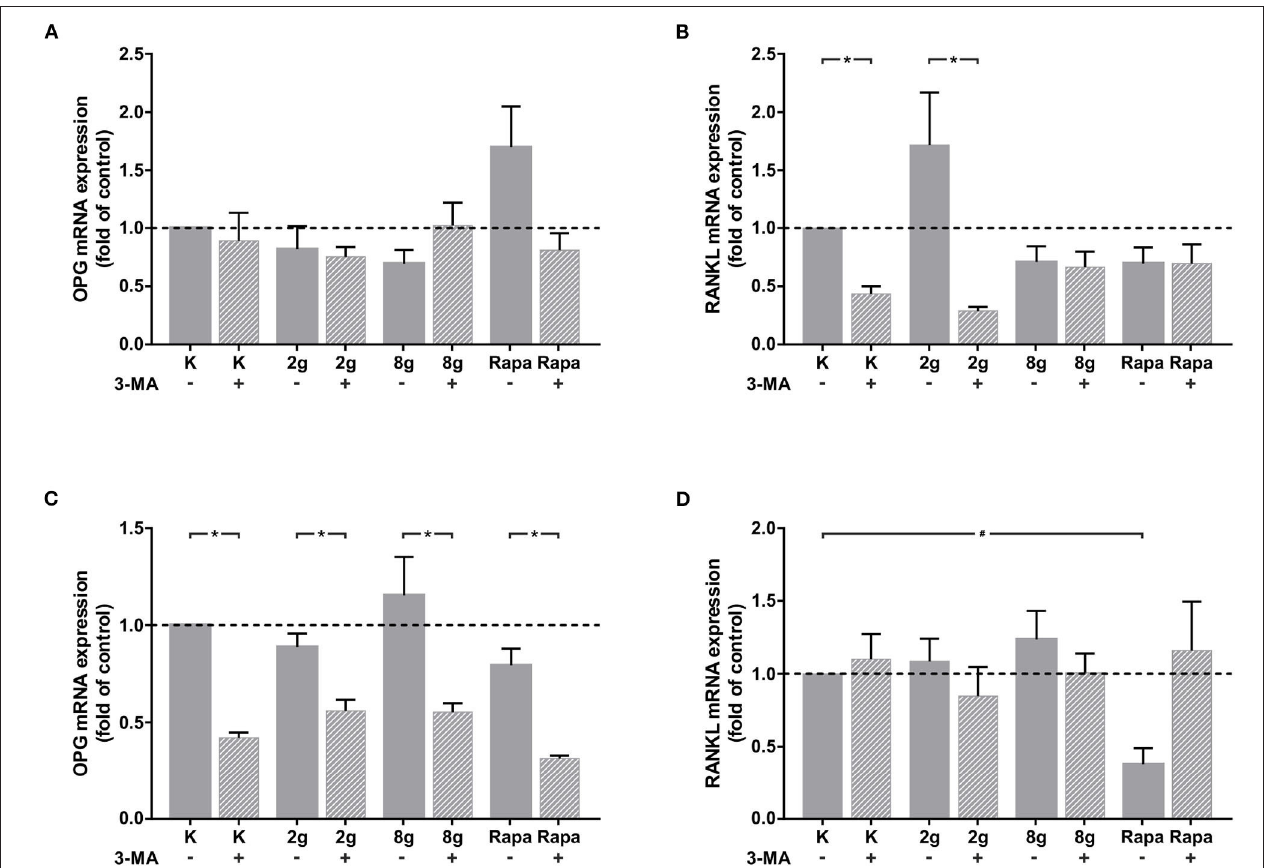
FIGURE 5 | (A) Effects on opg gene expression in phAOBs after 24 h cultivation without sIL-6R and with supernatant from hPDL fibroblasts with or without autophagy inhibitor 3-MA, treated with mechanical stimulation (2 or 8 g/cm 2 ) or Rapamycin (Rapa; 50 nM) for 16 h. Mean ± SEM ( n = 6); # significant ( p < 0.05) difference between groups as determined by Dunnett’s T -test. ∗ significant ( p < 0.05) difference between two groups (uninhibited and inhibited) as determined by the Mann-Whitney-Test. (B) Effects on rankl gene expression in phAOBs after 24 h cultivation without sIL-6R and with supernatant from hPDL fibroblasts with or without autophagy inhibitor 3-MA, treated with mechanical stimulation (2 or 8 g/cm 2 ) or Rapamycin (Rapa; 50 nM) for 16 h. Mean ± SEM ( n = 6); # significant ( p < 0.05) difference between groups as determined by Dunnett’s T -test. ∗ significant ( p < 0.05) difference between two groups (uninhibited and inhibited) as determined by the Mann-Whitney-Test. (C,D) Panels show the graphs respective to (A,B) with addition of